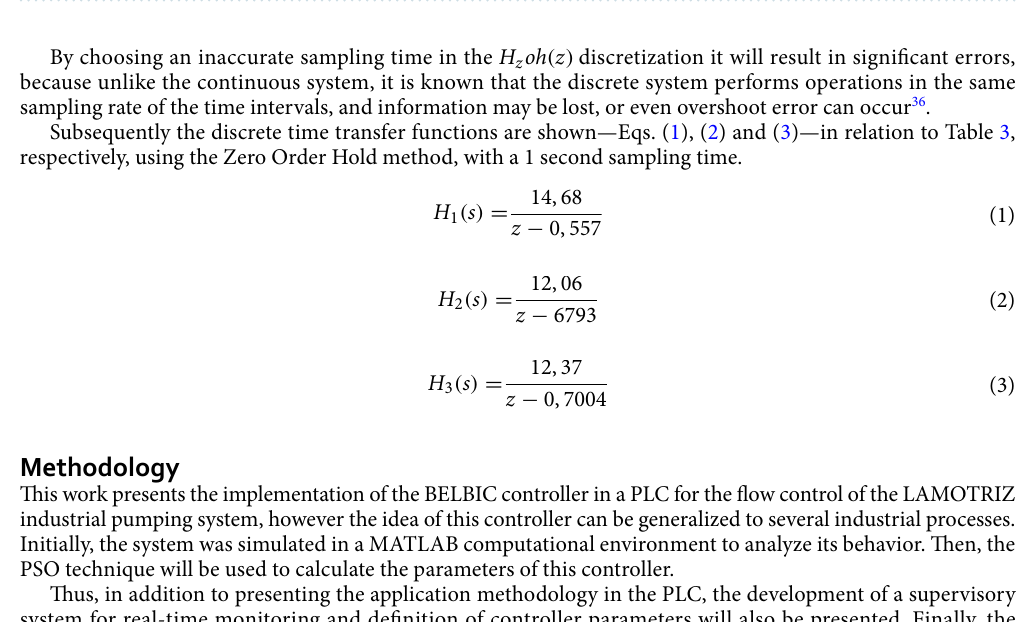
Figure 5. Computational model of the amygdala emotional learning—created using PowerPoint software version Microsoft